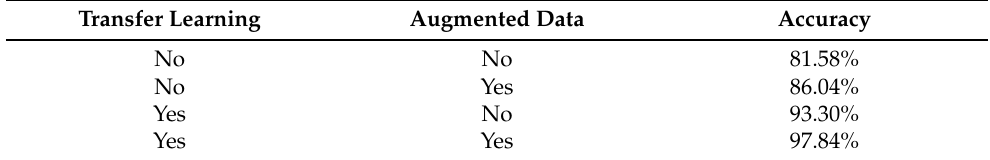
Table 5. Accuracy achieved by the four models with and without Augmentation and Transfer